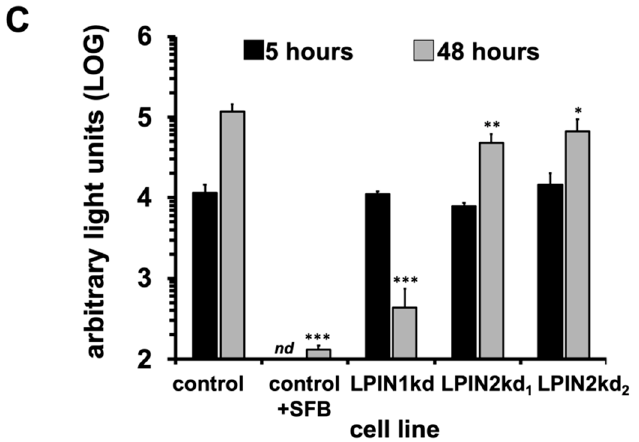
Figure 2. Study of early stages of HCV infection in lipin2-deficient cells. Huh-7 cells were transduced with lentiviral vectors expressing shRNAs targeting LPIN1 (LPIN1kd) or LPIN2 (LPIN2kd 1 and LPIN2kd 2 ). A control cell line was generated in parallel using a lentiviral vector expressing a non-targeting shRNA (control). At day 7 post transduction, the di ff erent cultures were inoculated with recombinant retroviral pseudotypes bearing ( A ) HCV (HCV pp ); VSV (VSV pp ) or RD114 (RD114pp) glycoproteins or ( B ) representative envelopes of major HCV genotypes. Intracellular reporter gene (luciferase) activity was determined forty-eight hours post inoculation. As control of HCV entry inhibition, control cells were treated with HCV entry inhibitor hydroxyzine pamoate (control + HDX; 5 µ M). Normalized entry e ffi ciency is shown as average and SD of a minimum of nine biological replicates from three independent experiments ( n = 9). ( C ) At day 7 post transduction, the di ff erent cell lines were transfected with a dicistronic subgenomic replicon bearing a luciferase gene. Intracellular reporter gene (luciferase) activity was determined 5 and 48 h post inoculation in the replication-competent construct. Data are shown as average and SD of three biological replicates from a representative experiment. Statistical significance was evaluated using one-way ANOVA and Dunnet´s post hoc test. (* p < 0.05; ** p < 0.01; *** p < 0.001).